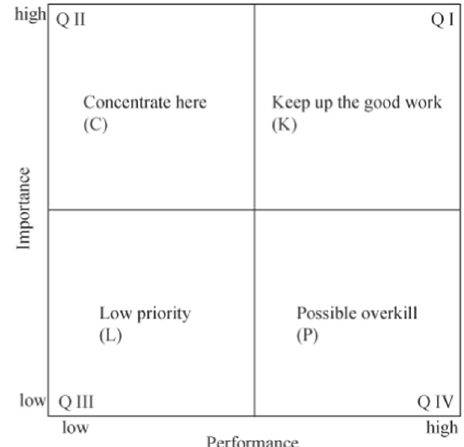
Fig. 1 Representative of IPA graph (Martilla and James, 1977). The importance measure represents the vertical axis, and the performance measure constitutes the horizontal axis of a